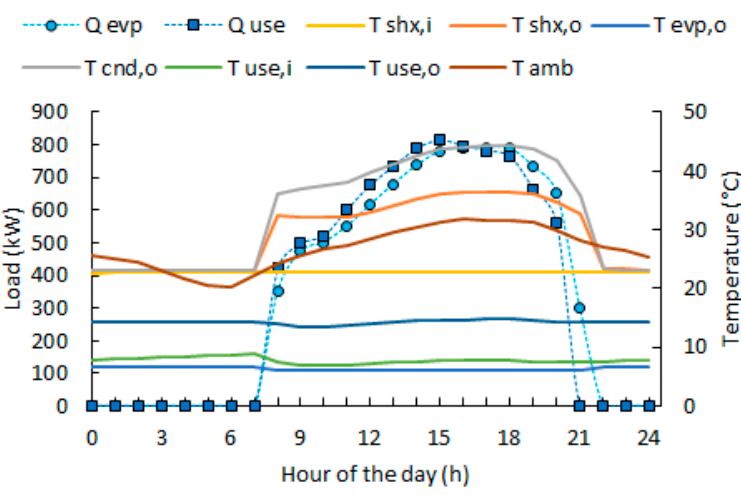
Figure 18. Transient operation in cooling mode (fouled SHX).